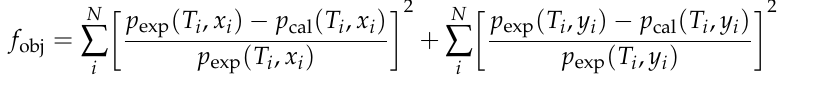
Table 13. Unlike group dispersion interaction energies ( ε kl ) , repulsive exponent ( λ r